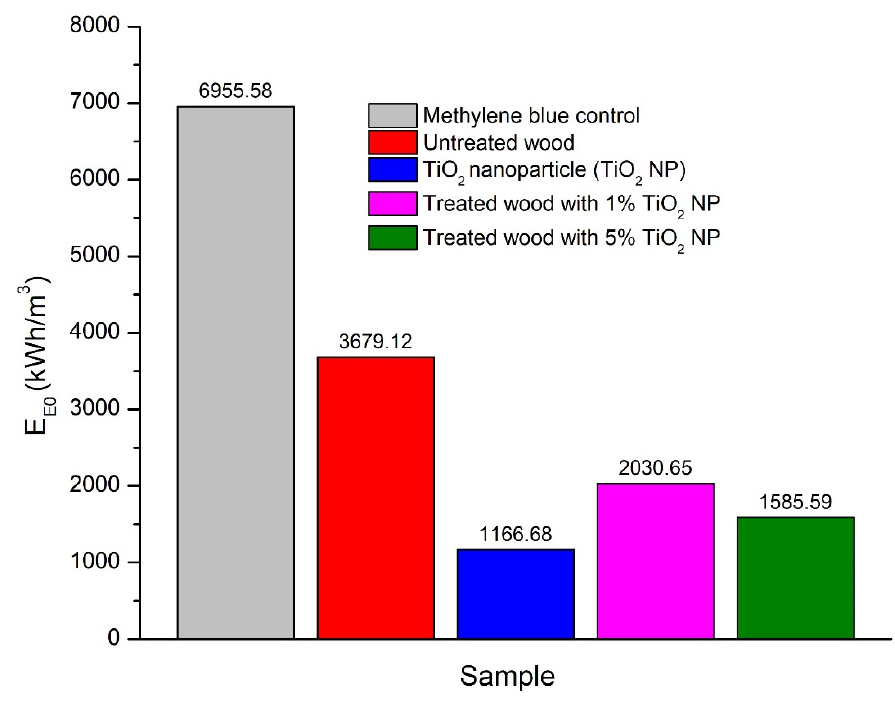
Figure 9. Energy consumption for the obtained samples.